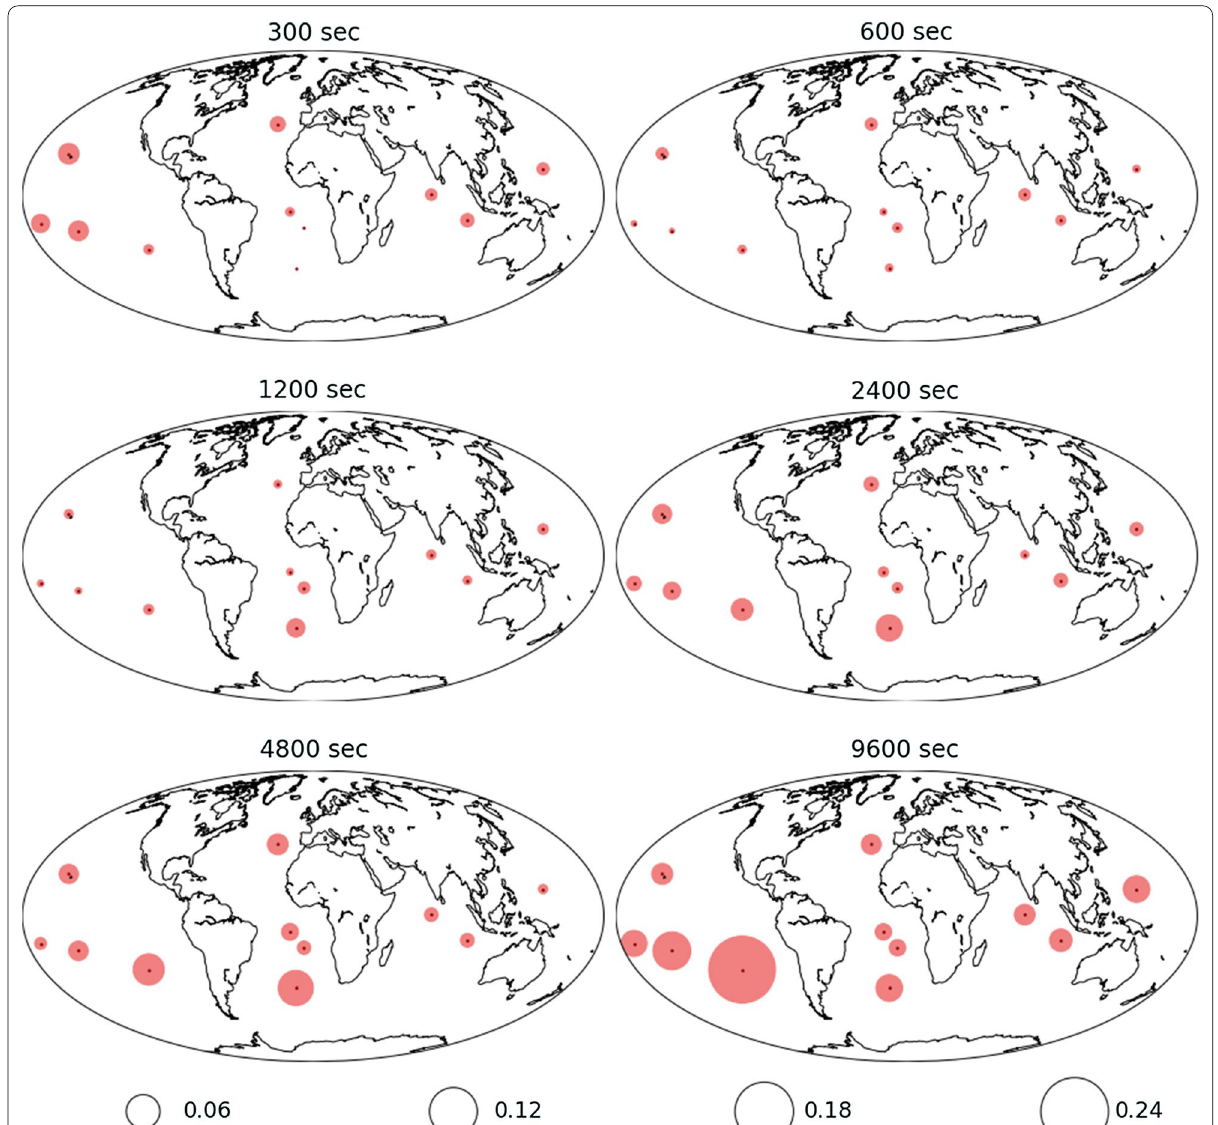
Fig. 17 Difference between “December” and “June” T zx at island observatories, shown as filled circles. “Experimental” and “modeled” differences are colored by light and dark red, respectively. The size of circles below the plots indicates four ranges of